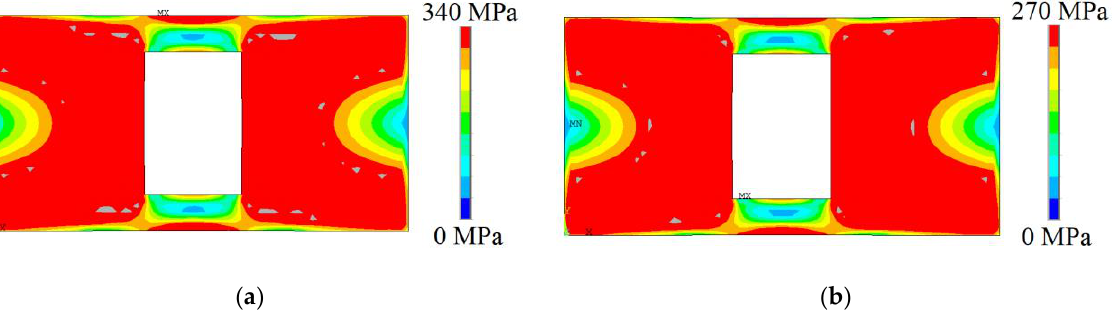
Figure 16: The von Mises stress distribution for the plate with rectangular hole made of cast irons: ( a ) spheroidal graphite iron (SGI) and ( b ) compact graphite iron (CGI).